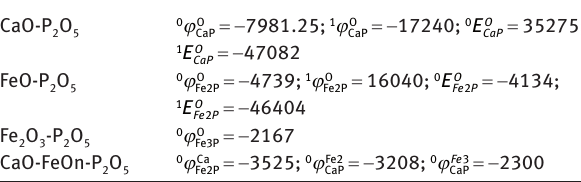
Table 1: Slag model parameters for the CaO-FeOn-P 2 O 5 system (J/mol) CaO-P O 2